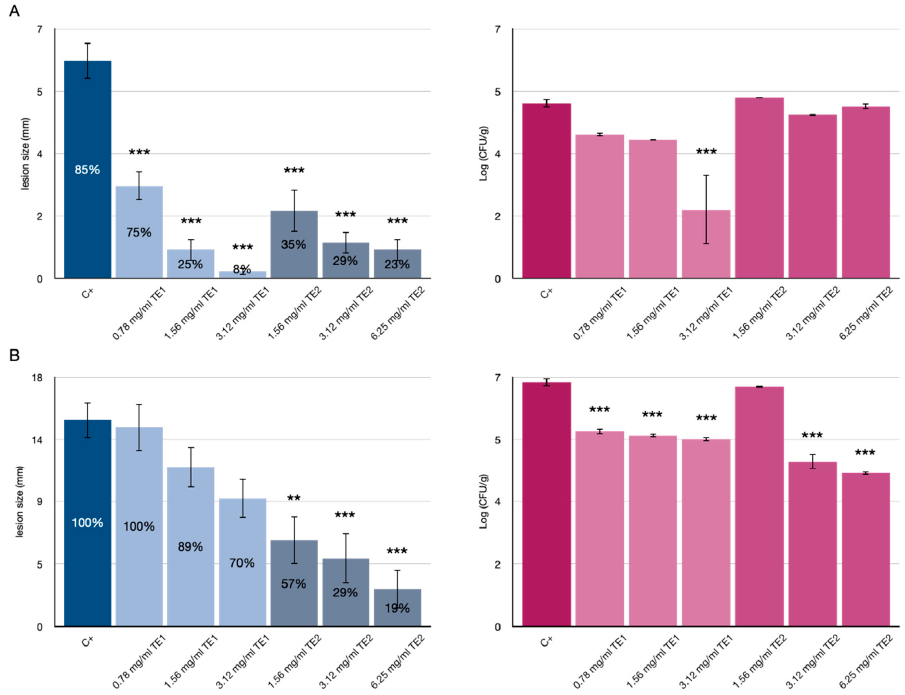
Figure 1. Effects of TE1 and TE2 on the growth of Fusarium verticillioides in tomatoes. Results expressed as % infected fruit (IF), lesion size (mm) and microbiological count (log10 CFU/g) at 4 days ( A ) and 11 days ( B ). Statistically significant differences for each treatment are indicated by ** p < 0.01, *** p < 0.001. Results are expressed as mean ± standard error.